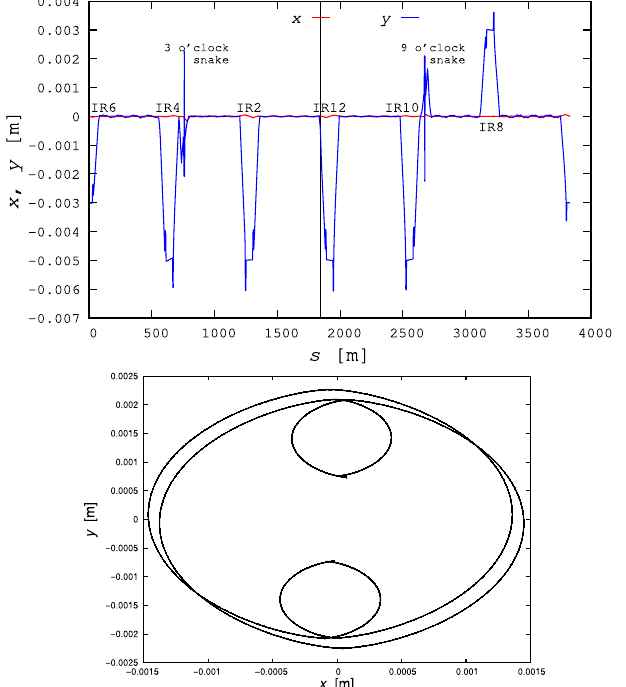
FIG. 16. Top: typical closed orbit with vertical separation bumps at IPs, in RHIC Yellow lattice nominal lattice, accounting for snake fields, at store (255 GeV); the vertical bar locates the p-C polarimeter, at s ¼ 1846 m from IP6, CCW. Bottom: trans- verse projection of helical orbits in snakes.